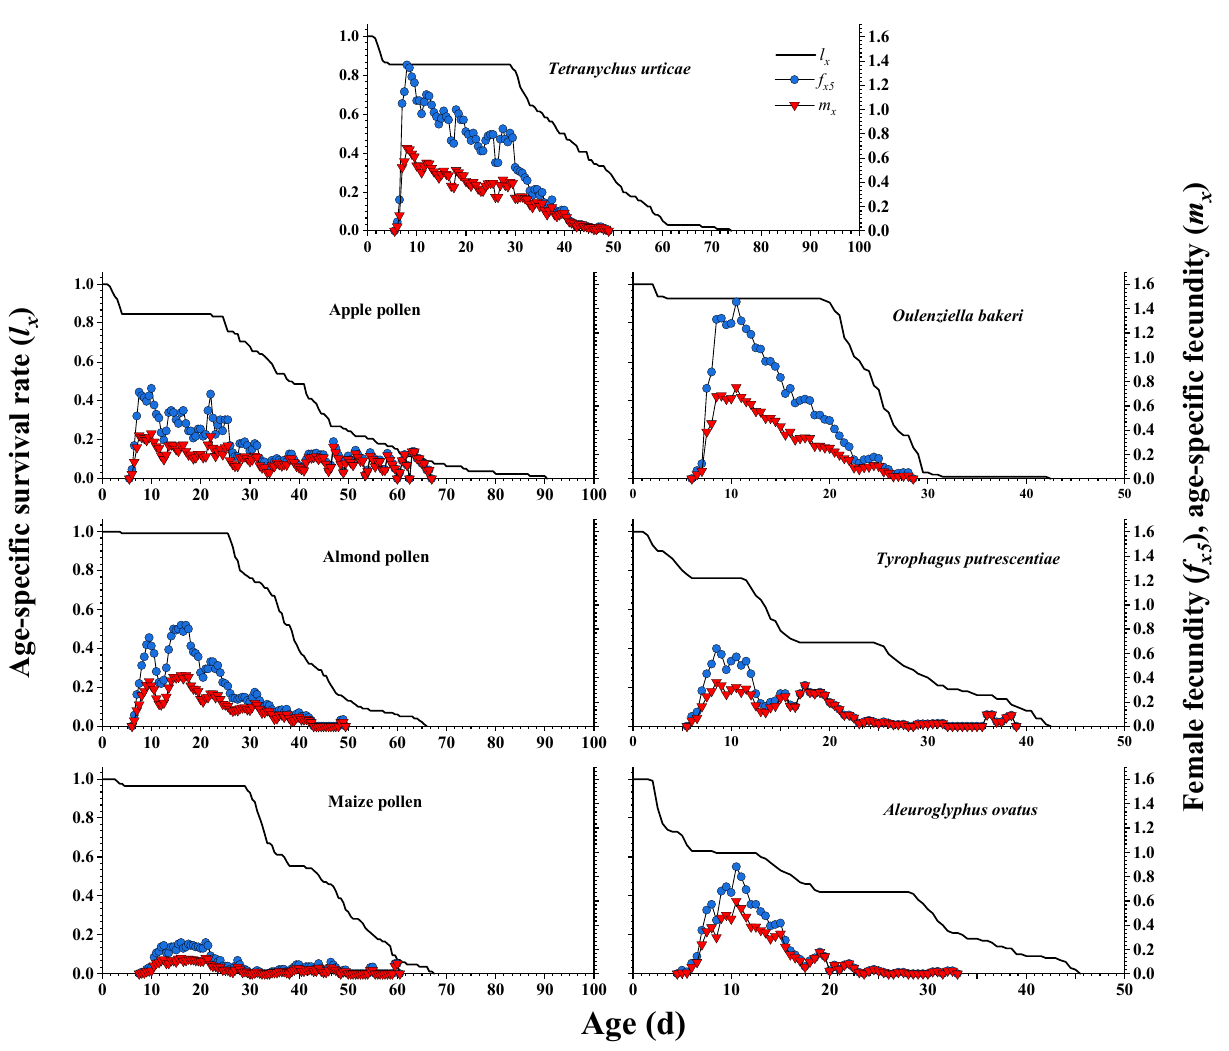
Figure 3. Age-specific survivorship ( l x ), age-specific fecundity ( m x ), and age–stage-specific fecundity ( f xj ) of A. herbicolus on six alternative foods and its natural prey, T. urticae . The estimated life table parameters for A. herbicolus on six alternative foods and its natural prey, T. urticae , are presented in Table 2. The highest intrinsic rate of increase ( r ) was obtained when A. herbicolus fed on O. bakeri (0.202 d − 1 ) in addition to T. urticae (0.210 d − 1 ), followed by almond pollen (0.163 d − 1 ), whereas the lowest was when it fed on maize pollen (0.064 d − 1 ). The highest finite rate of increase ( λ ) was obtained when A. herbicolus fed on O. bakeri (1.224 d − 1 ) in addition to T. urticae (1.233 d − 1 ), and it was considerably lowest on maize pollen (1.066 d − 1 ). The net reproductive rates ( R 0 ) of A. herbicolus fed on almond pollen, O. bakeri, and apple pollen were significantly higher than those on A. ovatus , T. putrescentiae, and maize pollen. The mean generation time ( T ) was longer when A. herbicolus fed on plant pollens than on prey